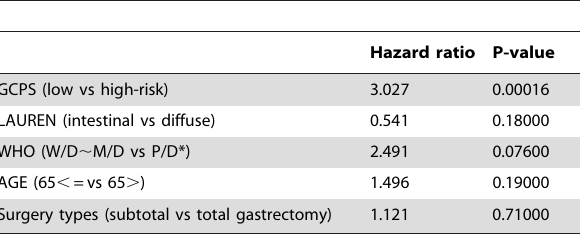
( Table S1 ). a. Table S1. Patients characteristics. 2. Clinical and pathological characteristics of cases examined at each phase. 3. Detailed description of the discovery step using WG-DASL assay